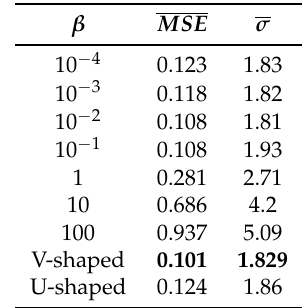
Table 3. Effect of the parameter β on the performance. The V-shaped configuration refers to a frequency-dependent β with a minimum of 10 − 4 at 1 kHz and maxima of 10 − 1 at DC and Nyquist, varying linearly on a dB scale. The U-shaped configuration takes a value of 10 − 4 in the range 100 Hz–10 kHz and one elsewhere. Best results for each column are highlighted in bold.